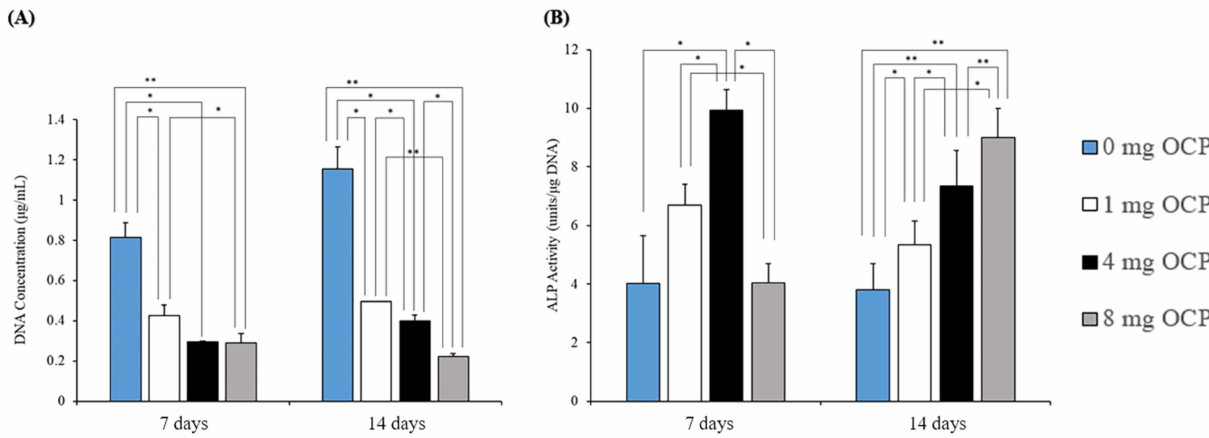
Figure 2. Responses of TSPCs to the different content of calcium phosphate granules; ( A , B ) the DNA content and ALP activity of TSPCs treated with different doses (0–8 mg) of OCP granules ( n = 3) ** p < 0.01, * p <